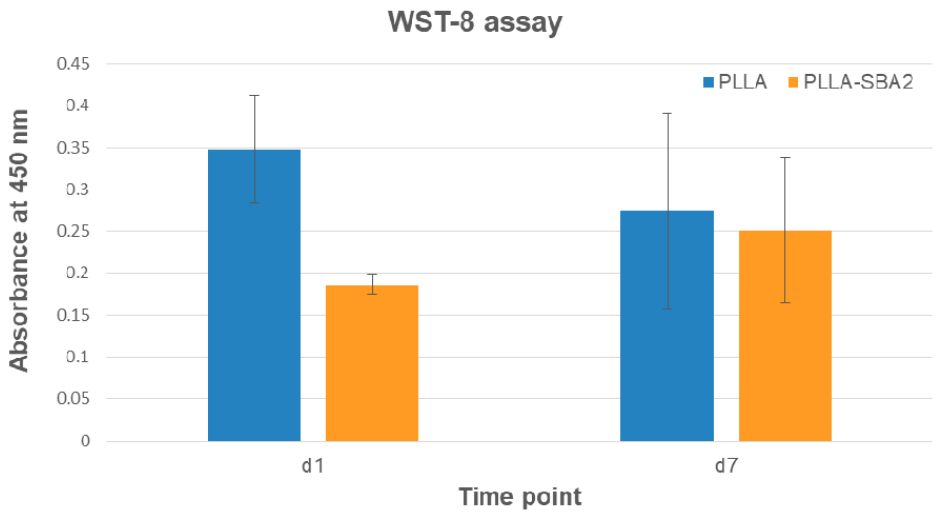
Figure 10. WST-8 assay: histograms of absorbance at 450 nm for PLLA and PLLA-SBA2, one (d1) and seven (d7) days after the seeding.